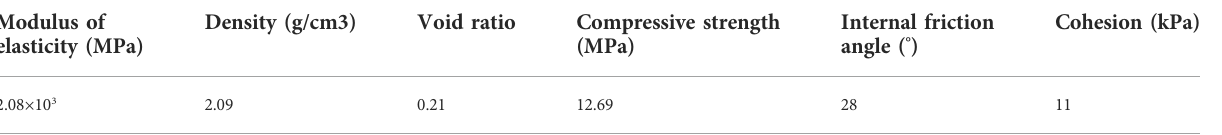
TABLE 1 Basic physical parameters of slide mass